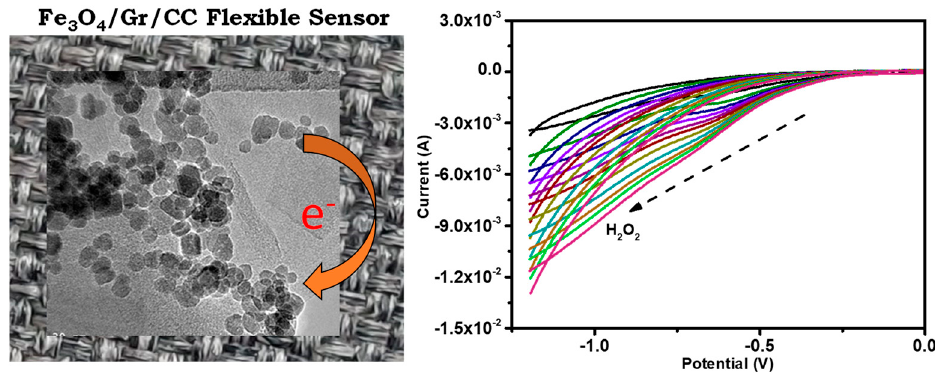
13 of 19 Figure 7. CVs of Fe 3 O 4 /Gr/CC obtained at various applied scan speeds of 20–210 mVs − 1 in 0.1 M PBS (pH 7.0). 4.2. Limit of Detection and Sensitivity of Flexible Sensor The limit of detection (LOD) and sensitivity of fabricated Fe 3 O 4 /Gr/CC sensors can be estimated using the previous method reported [74,75]. For this, we used Equations (1) and (2), which were mentioned below, to fi nd out the LOD and sensitivity of the Fe 3 O 4 /Gr/CC for the sensing of H 2 O 2 : Limit of detection (LOD) = 3.3 ( σ /S) (1) Sensitivity = Slope/area of the working electrode (2) where σ = standard error, and S = slope. The sensitivity, LOD, and linear range of the Fe 3 O 4 /Gr/CC toward H 2 O 2 using an elec- trochemical approach were recorded as 0.037 µA µM − 1 cm − 2 , 4.79 µM, and 10–110 μM re- spectively, and the plausible mechanism can be seen in Scheme 3. Scheme 3 shows the